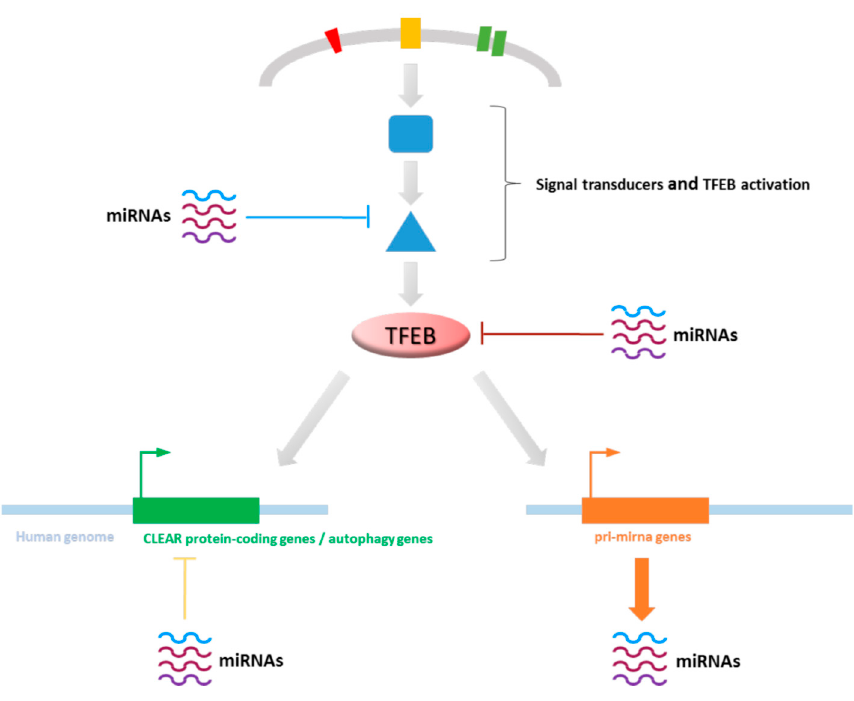
Figure 3. TFEB and miRNAs . TFEB exerts its function being embedded in a complex network of molecular species, regu- lated by miRNAs at various steps. Several miRNAs are known to regulate TFEB itself or its activation (see Figures 4 and 5). Among TFEB targets, several CLEAR responsive genes involved in autophagy are post-transcriptionally regulated by miRNAs (see Figure 6). Finally, TFEB can directly promote the transcription of miRNA precursors (see Figure